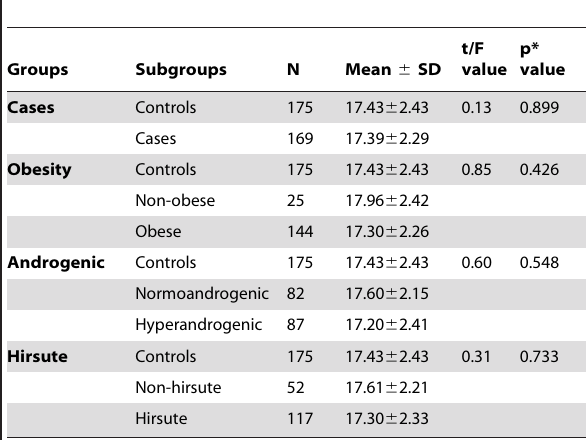
Table 2. Comparison of CAG bi-allelic mean length between controls and case subgroups.